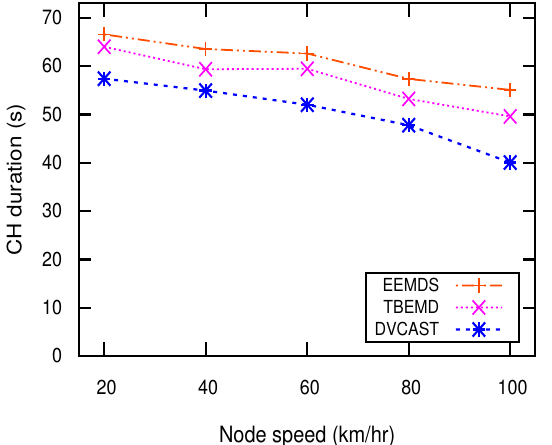
Figure 7. CH duration vs. node speed.